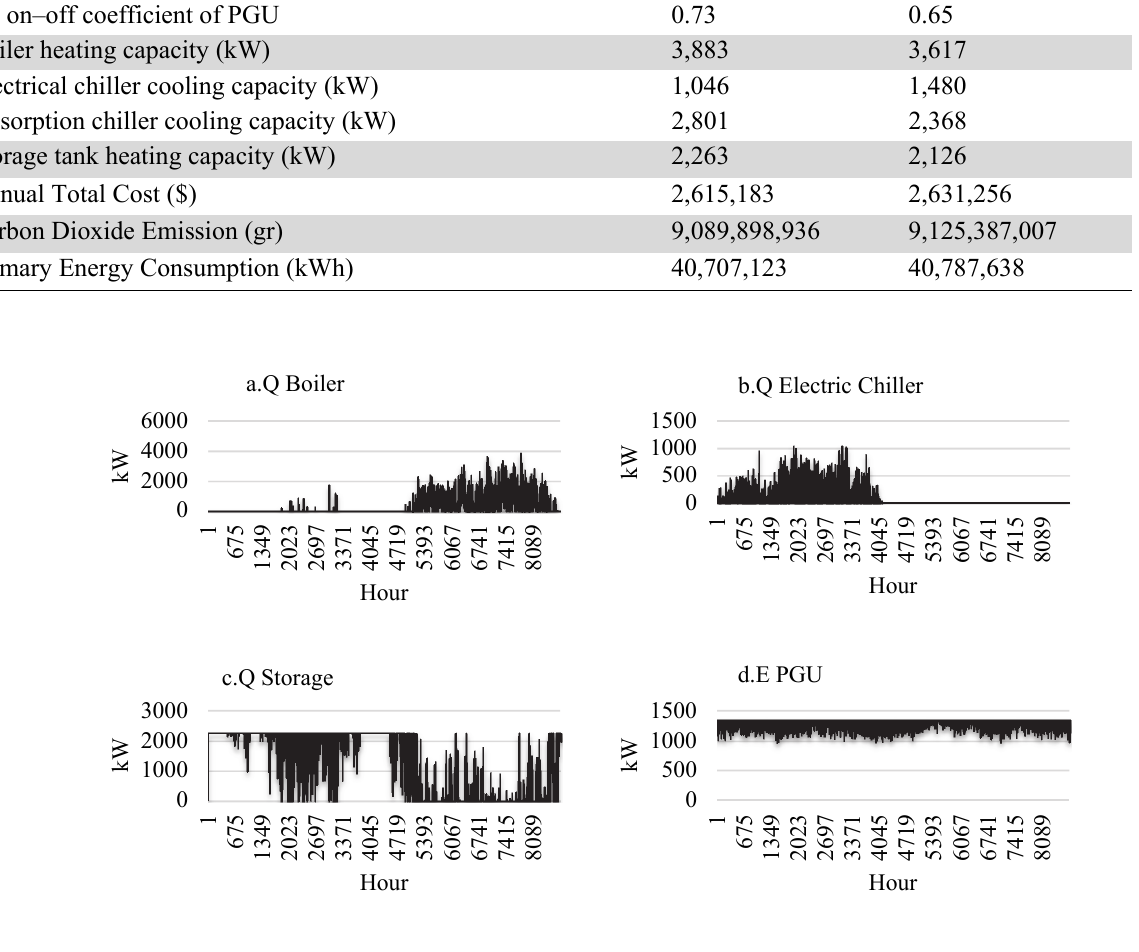
Fig. 7. Performance of system all year long under